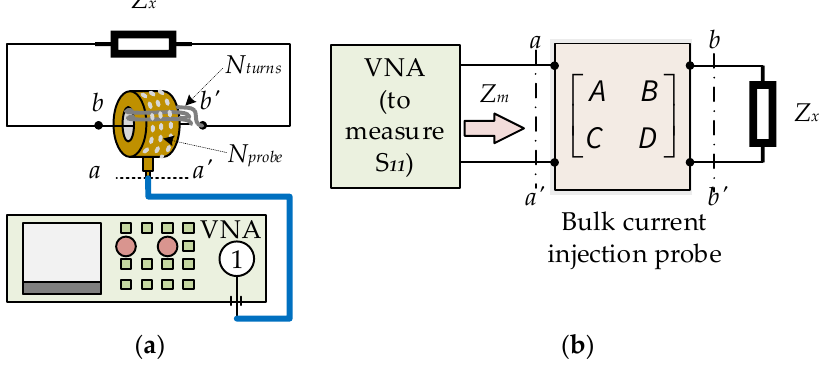
Figure 1. ( a ) Enhanced single-probe setup and ( b ) its corresponding equivalent circuit.